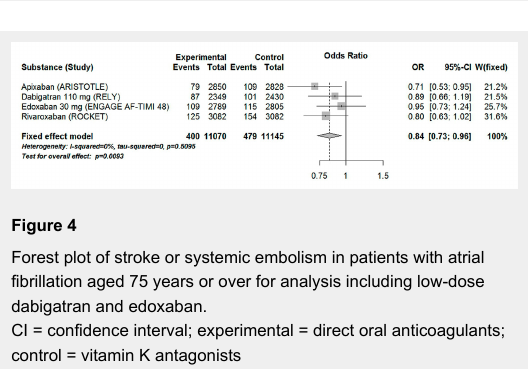
Forest plot of stroke or systemic embolism in patients with atrial fibrillation aged 75 years or over for analysis including high-dose dabigatran and edoxaban. CI = confidence interval; experimental = direct oral anticoagulants; control = vitamin K antagonists